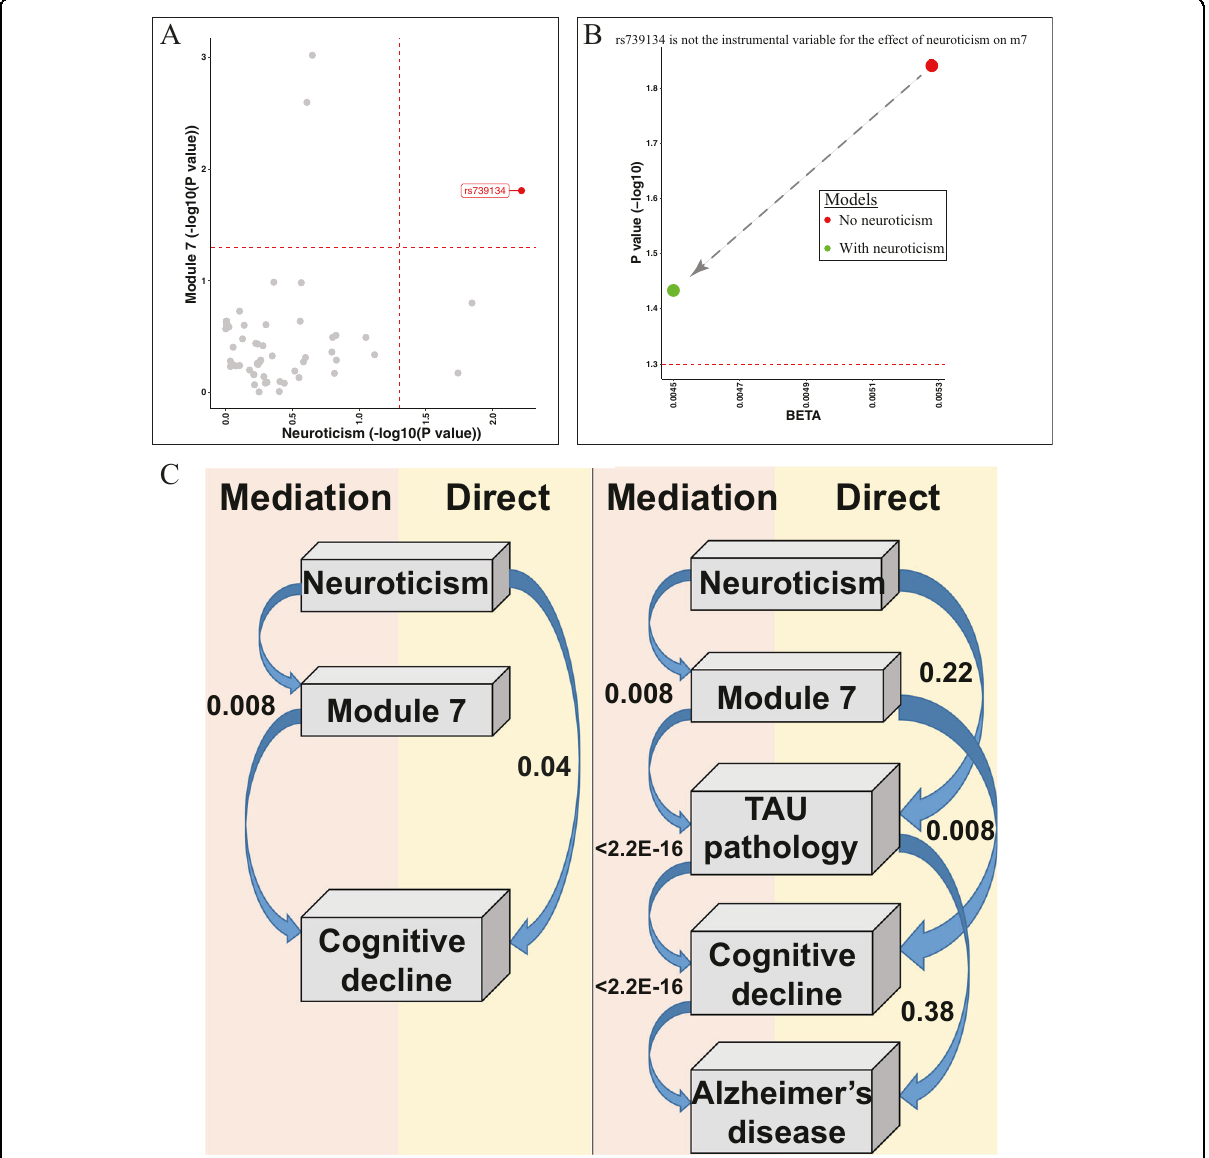
Fig. 3 Causal chain analysis by mendelian randomization and mediation tests. A Rs739134 was associated with both neuroticism and module 7 expression. Each dot represented one of the 69 reported neuroticism-associated SNPs (Nagel 2918) and their P values ( − log10 transformed) for neuroticism ( X axis) and module 7 expression ( Y axis) in ROSMAP were presented. B Rs739134 is not the instrumental variable for the effet of neuroticism on module 7 gene expression. The effects of rs739134 on the module 7 expression for the were presented by BETA ( X axis) and P values ( − log10 transformed) in the two models without the adjustment of neuroticism (red dot) and with the adjustment of neuroticism (green dot). The red dashed horizontal line represented the signi fi cance threshold of P = 0.05. C Module m7 mediates the effect of neuroticism on cognitive decline. Left panel: we present the most likely sequence of events based on our cross-sectional data. The most likely scenario is that being more neurotic leads to an increase in m7 which then contributes to an acceleration in cognitive decline. The p value for this 0.008 while, in the same analysis, the direct effect of neuroticism on cognitive decline is much less ( P = 0.04). Not shown is an analysis which shows that m7 is much more likely to be downstream of neuroticism than upstream where an increase in m7 would make someone more neurotic. Right panel: we expand the model shown in the left panel with Tau pathology which is known to immediately precede cognitive decline and a diagnosis of AD which occurs after someone has begun to decline. Here, three mediation tests are presented: (1) Neuroticism → m7 → Tau is more likely than a direct effect of Neuroticism → Tau, (2) m7 → Tau → Cognitive decline is more likely than m7 → Cognitive decline, and (3) Tau contributes to AD dementia by affecting the slope of cognitive decline (Tau → Cognitive decline → AD), which is the well-accepted model of AD. TAU abnormally phosphorylated Tau protein,